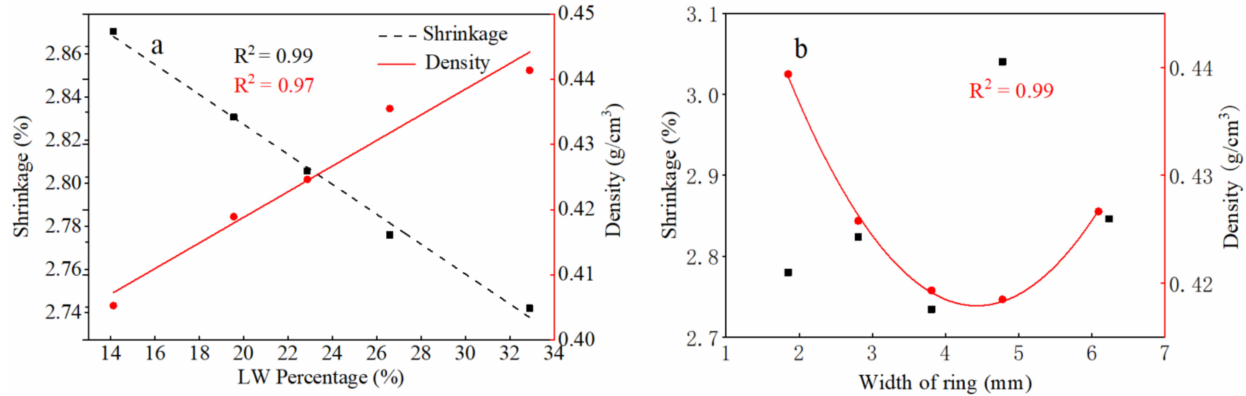
Figure 4. Influence of ( a ) latewood (LW) percentage and ( b ) ring width (RW) on shrinkage and